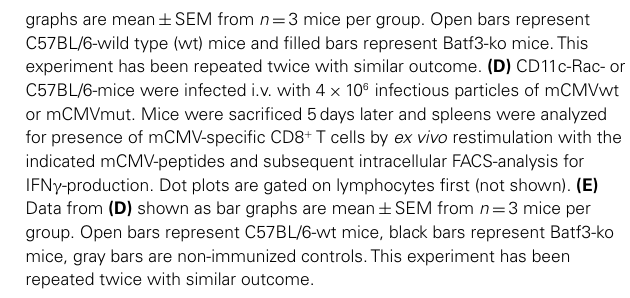
FIGURE 4 | mCMV responses do not depend on cross-presentation. BMDC were infected with mCMVwt, mCMVmut, or mock-infected. DCs were utilized to either stimulate 5 × 10 4 CFSE-labeledTCR-transgenic gp33-41-specific CD8 + P14T cells as described in Figure 1B (A) . CFSE-profiles of gated CD8 + T cells are shown for the peptide concentration 0.1ng/ml. Graphs show results of gated dividedT cells of one experiment out of two with similar results. (B) Batf3-ko and C57BL/6-mice were infected i.v. with 4 × 10 6 infectious particles of mCMVwt or mCMVmut. Mice were sacrificed 7days later and spleens were analyzed for presence of mCMV-specific CD8 + T cells by ex vivo restimulation with the indicated mCMV-peptides and subsequent intracellular FACS-analysis for IFN γ -production. Dot plots are gated on lymphocytes first (not shown). (C) Data from (B) shown as bar